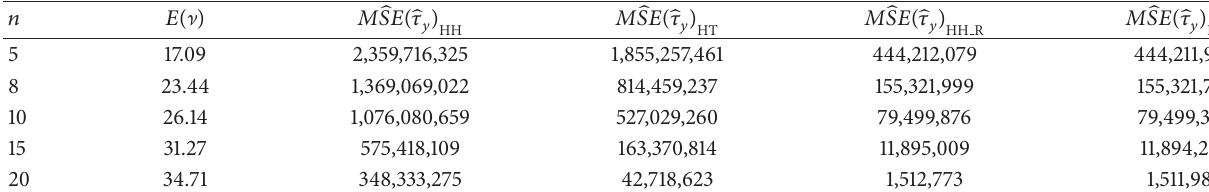
Table 1: The estimated MSE of the Hansen-Horvitz estimators and Horvitz-Thompson estimators for the population total of blue-winged teal.